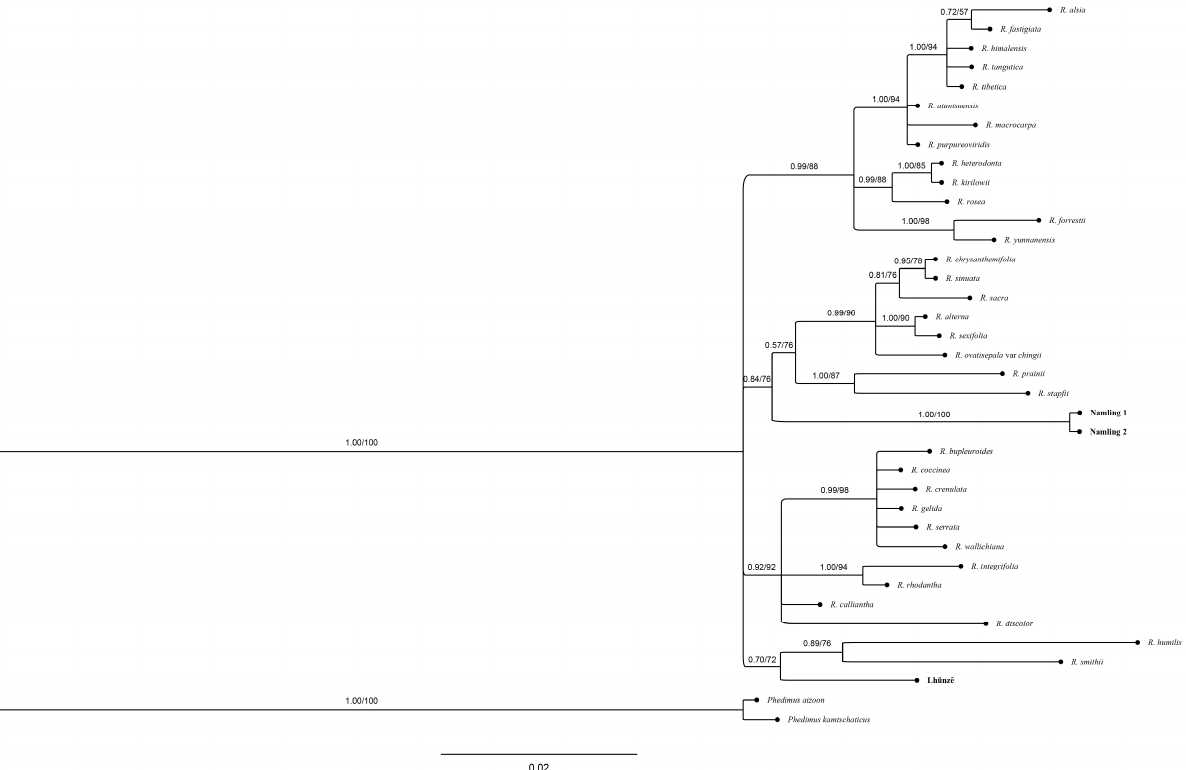
Figure 3. A Bayesian phylogenetic tree based on ITS sequences for the two new Rhodiola species described and their close relatives. The topology of the maximum likelihood (ML) tree was highly compatible with that of the Bayesian tree. Bayesian posterior probabilities (PPs: left) and bootstrap support (BP: right) values (>50%) are shown above the